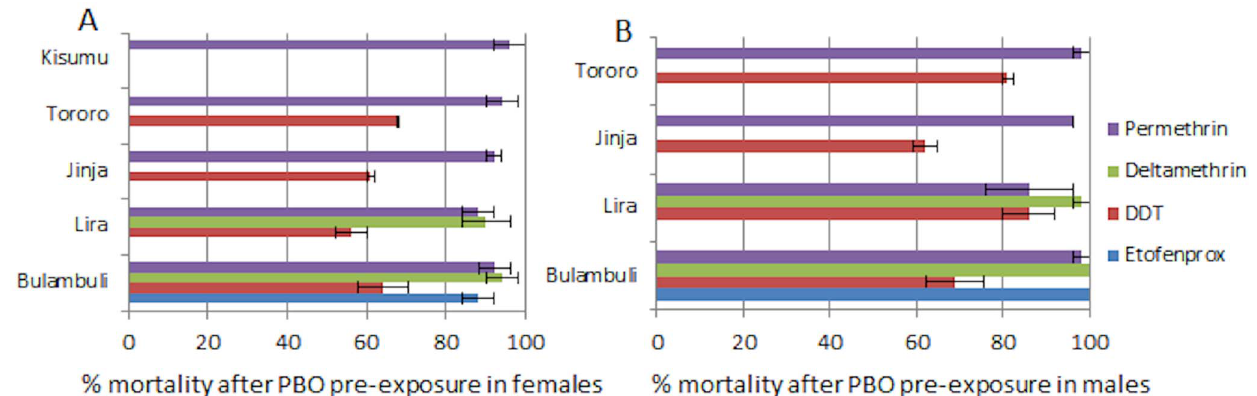
Figure 4. Susceptibility profile after synergist assay with PBO.